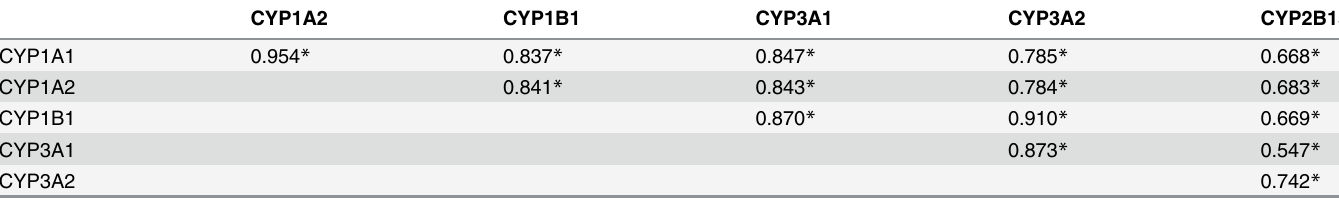
Table 1. Correlation coefficients among CYP gene expression potentials in STP